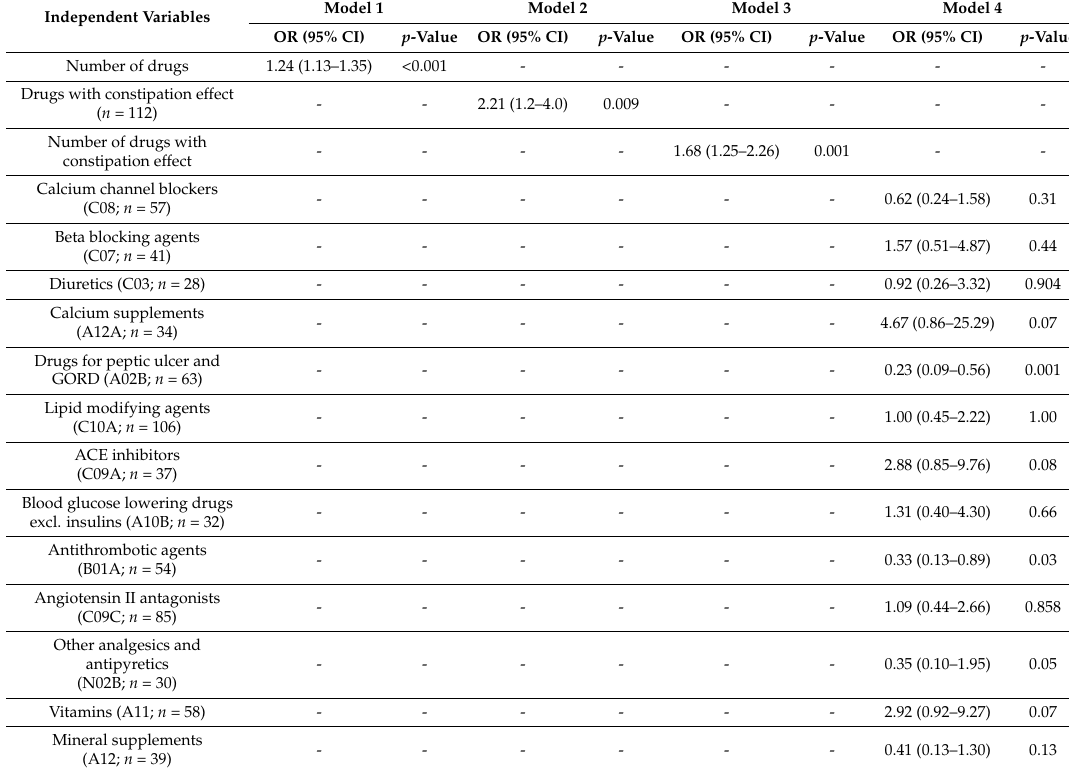
Table 3. Logistic regression models for constipation with number of drugs (Model 1), patients on at least one drug with constipation side effect (Model 2), number of drugs with constipation side effects (Model 3), or groups of drugs (Model 4) as predictors.